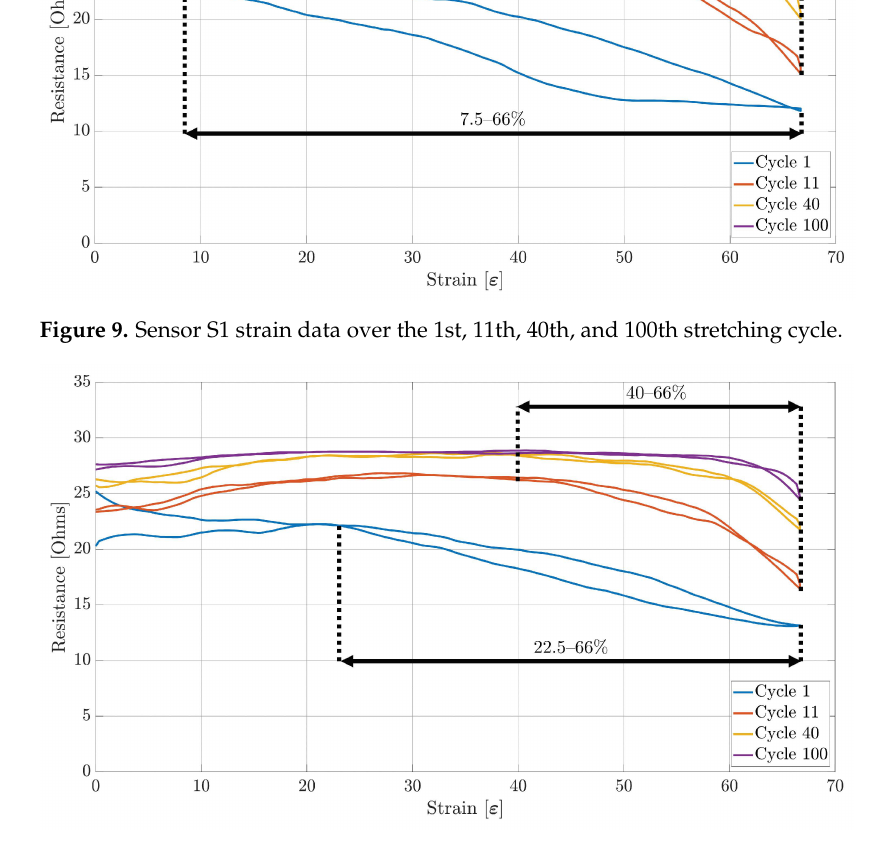
Figure 10. Sensor S2 strain data over the 1st, 11th, 40th, and 100th stretching